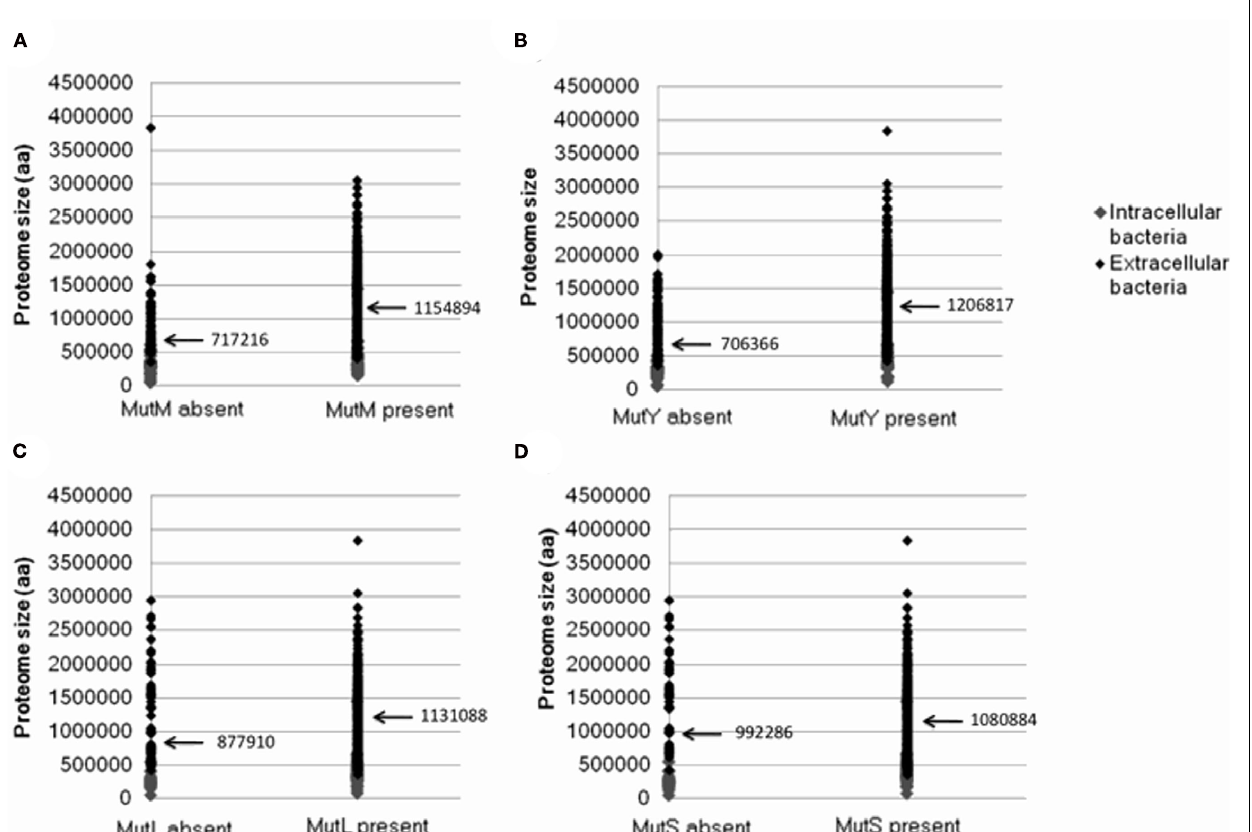
FIGUREA1 |The relationship between the presence or absence of genes involved in DNA repair and proteome size. Plots show presence or absence of (A) mutM (B) mutY (C) mutL (D) mutS . Data was generated from 699 complete eubacterial genomes. Intracellular and extracellular bacteria are indicated.